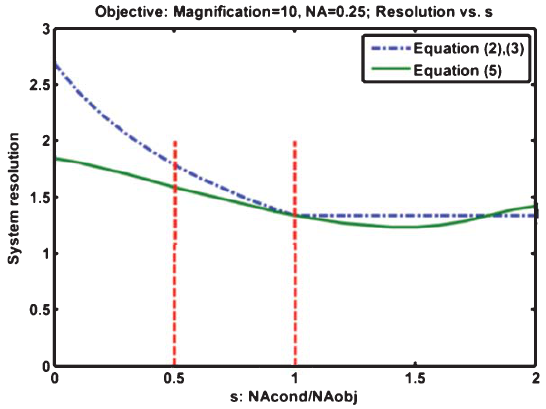
Fig. 3. Thetheoretical relation between resolution and s under 10 × ( NA obj = 0 . 25) based on Equations (2), (3) and (5); two red lines show that in the range of s =0.5–1.0, the result from Equations (2) and (3) is approximately close to that from Equation